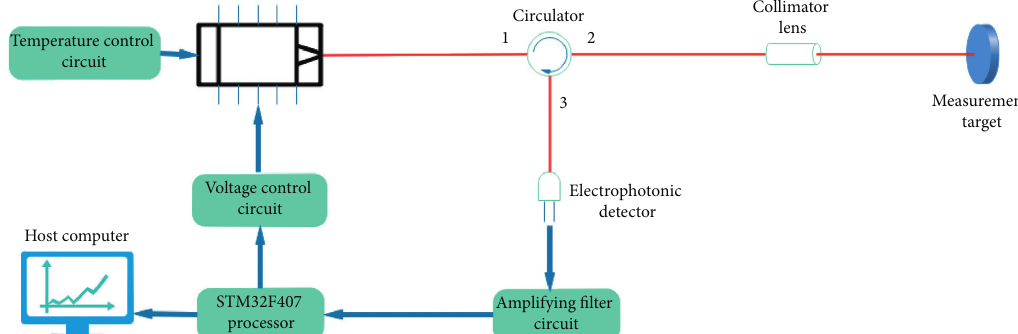
Figure 3: FMCW optical fiber measurement system structure